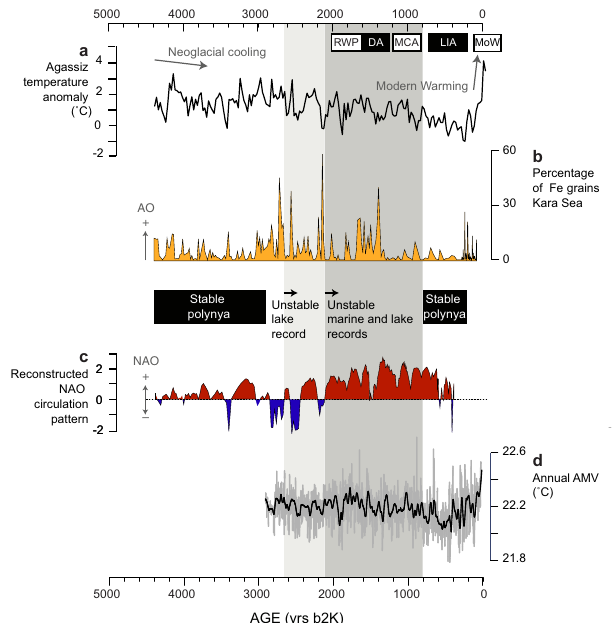
Fig. 6 Climate variability in the Arctic and North Atlantic region during the late Holocene from selected high-resolution records. a Air temperature anomalies from the Agassiz ice core record from 52 . b Arctic Oscillation (AO) reconstruction from a Kara Sea record as presented in ref. 45 . c North Atlantic Oscillation (NAO) reconstruction from a southwest Greenland lake record as presented in ref. 44 . d Atlantic multidecadal variability (AMV) as reconstructed from a lake record from Ellesmere Island 39 . RWP Roman Warm Period, DA Dark Ages Cold Period, MCA Medieval Climate Anomaly, LIA Little Ice Age, MoW Modern Warming. Grey bars indicate periods of polynya instability as inferred by our lake and marine records. The darker grey bar overlaps with the period of human abandonment of Greenland from c. 2200 – 1200 cal yrs